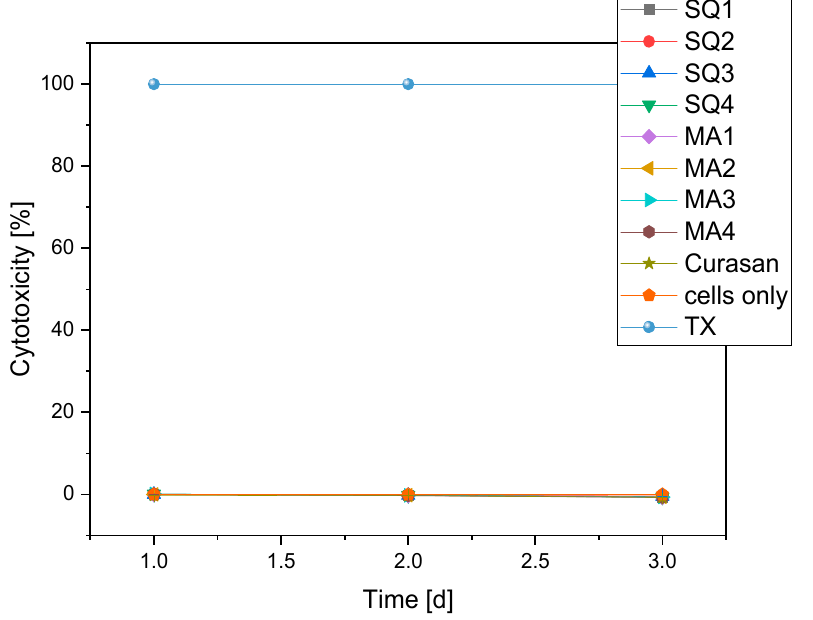
Figure 13. Overview of the cytotoxicity of the different compositions compared to negative (cells only) and positive (TritonX = TX) control.